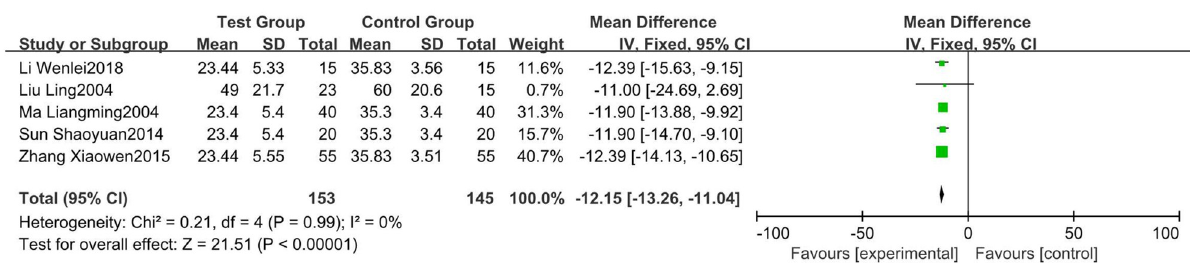
Fig 6. Forest plot of recovery time of platelets.